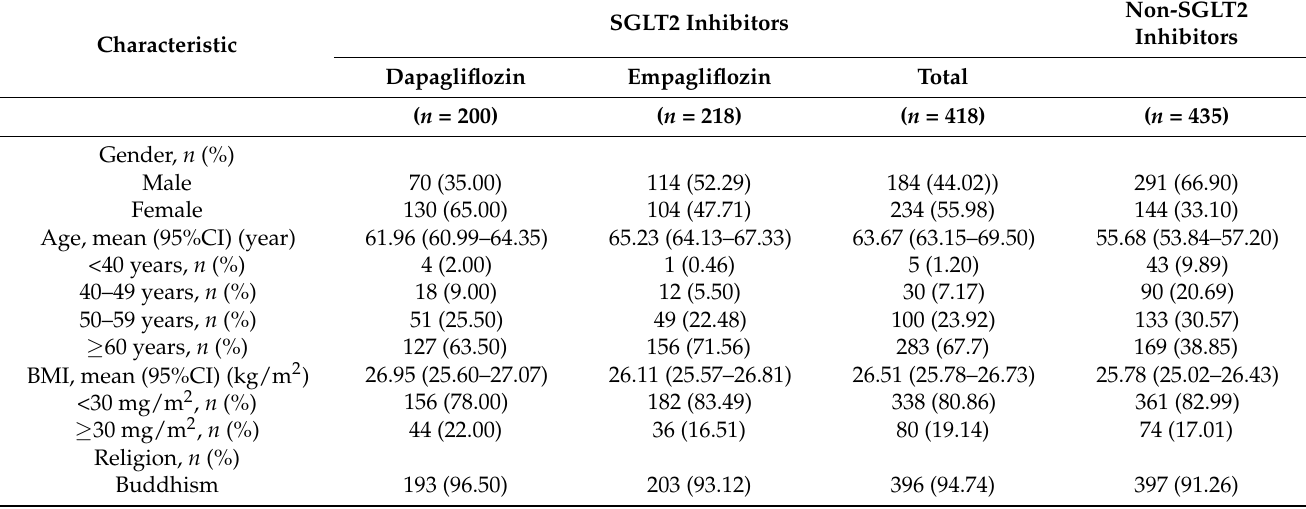
Table 1. Demographic and clinical characteristics of patients who received SGLT2 inhibitor and non-SGLT2 inhibitor